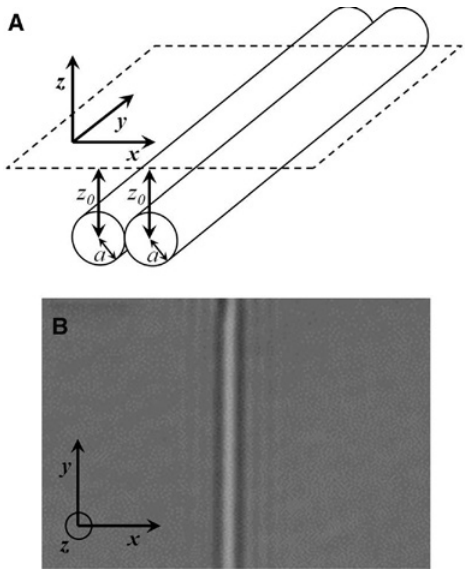
Figure 1: (A) Orientation of the double cylinders with respect to the object plane of the microscope (dashed line). The incident central wave vector, k ′ , is in the + z direction, and p and s polarizations are oriented in the y - and x -directions, respectively. (B) Sample image of a silk double cylinder (defocused by an amount, z orientation of the Cartesian axes. Images are integrated along the y -direction to obtain irradiance profiles along the x